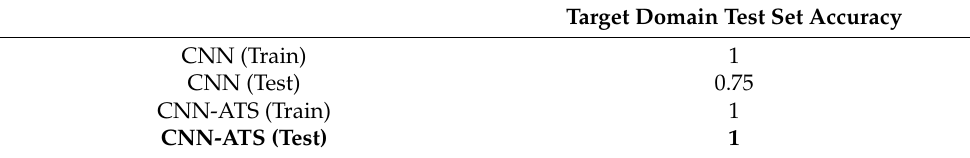
Table 9. Accuracy of the